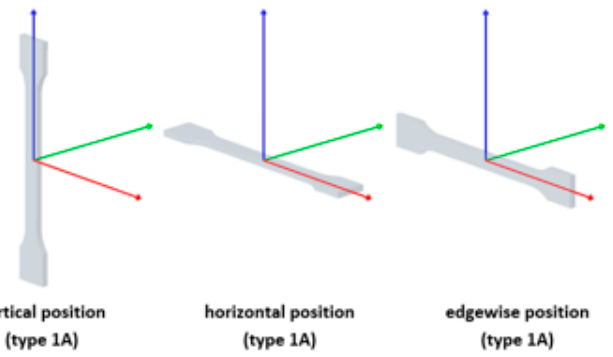
Figure 1. Possible orientations of a 1A sample in Cartesian coordinates (colored arrows).